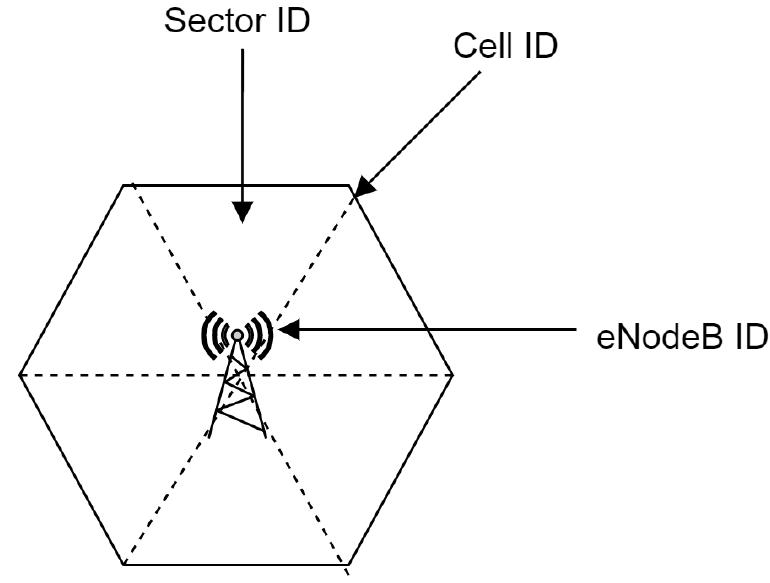
Figure 7. Description of the E-UTRAN